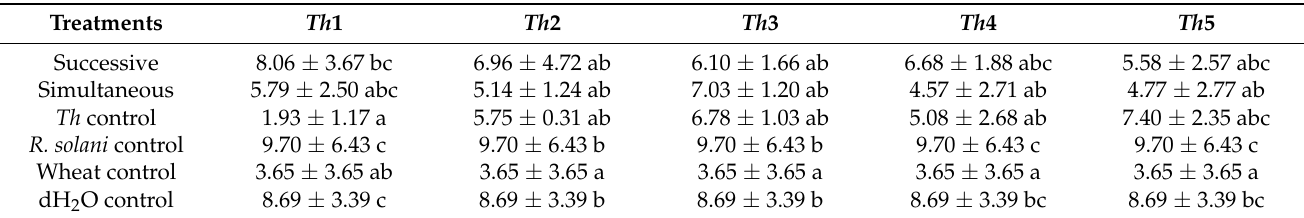
Table 7. Basal vascular necrosis length of grafted plants in cm (mean ± standard deviation) for each type of treatment (successive or simultaneous inoculation with R. solani and T. harzianum , and controls with plants inoculated only with wheat and submerged in distilled water) as a function of the T. harzianum isolate used.